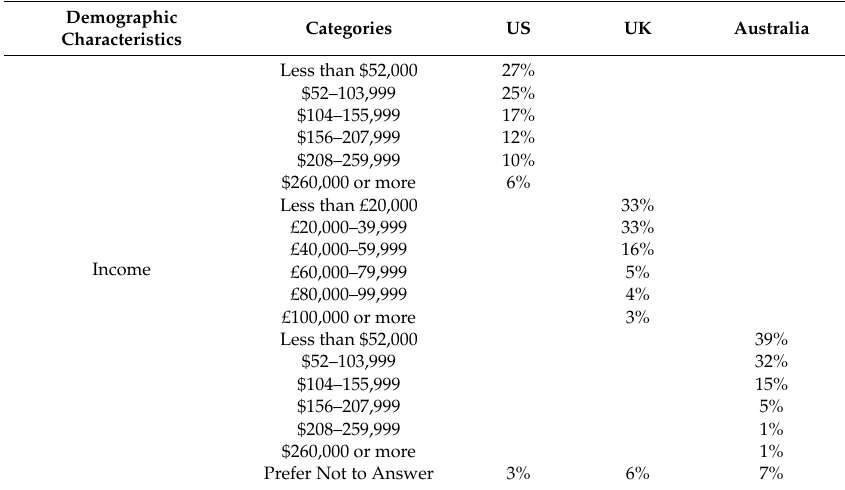
Table 2. Income demographic percentages